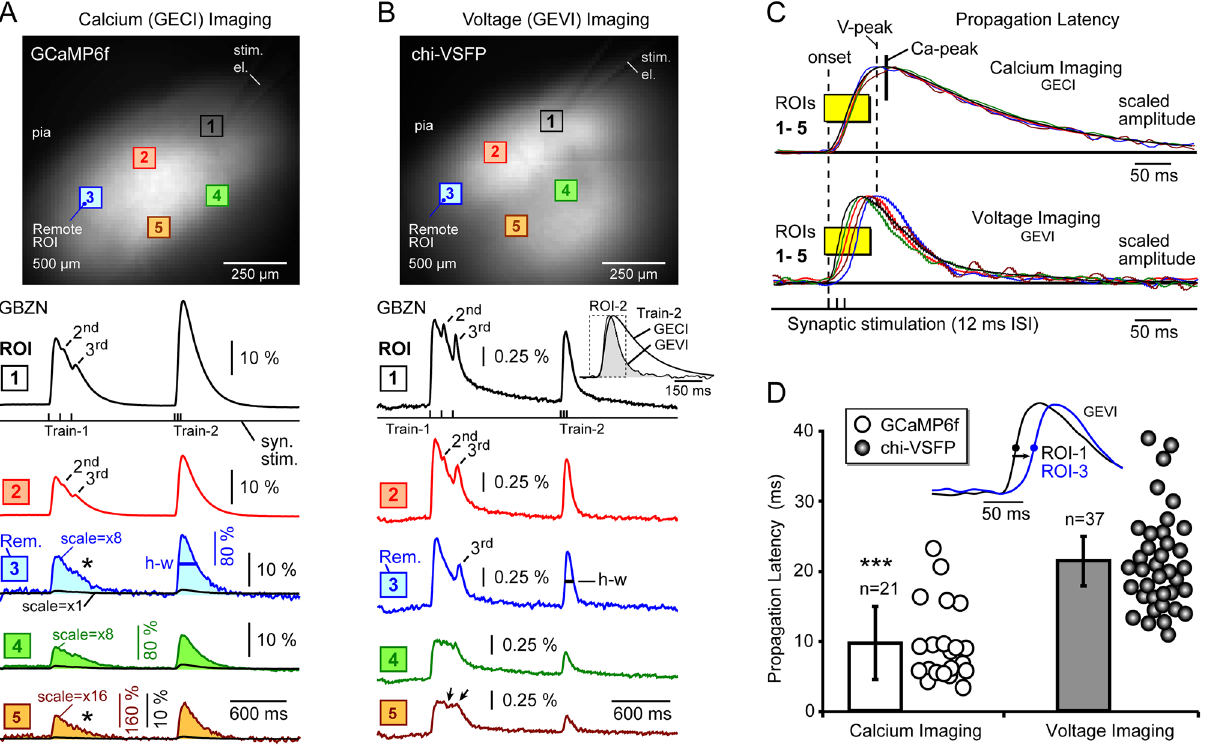
Figure 3. Optical signal propagation—calcium vs. voltage imaging. ( A ) Top, image: Surface of a cortical brain slice prepared from GCaMP6f animal, with ROIs and glass electrode for synaptic stimulation. Bottom, traces: Synaptically-evoked calcium (GECI) transients in the presence of GABA-A receptor antagonist, gabazine, GBZN [10 µM]. Synaptic stimulation comprised two triplets, 8.3 Hz ( Train-1 ) and 83 Hz ( Train-2 ), respectively. Optical traces were recorded simultaneously from 5 ROIs. The remote traces (ROI-3-4-5) are shown at two amplifications: × 1 (black) and × 8, × 16 (color). Asterisk marks uneventful waveform. ( B ) Same as in ( A ), except the brain slice was prepared from a chi-VSFP animal. Black arrows mark fast changes in GEVI waveforms, which are unmatched in the GECI records (asterisk). Inset: Differences in the peak timing and signal duration between a GECI and GEVI trace at ROI-2. ( C ) Traces from ( A ) and ( B ) ( Train-2 ) are amplitude-scaled, time-aligned, and superimposed on a faster time scale. Yellow box on the rising slopes of traces indicates the amplitude level (half-amplitude) at which latencies were quantified. Note that voltage transients (bottom) show a greater variety of signal latencies compared to the calcium transients (top). Vertical dashed line “onset” marks the onset of synaptic stimulation. Vertical dashed line “ V-peak ” marks the peak of the most delayed voltage transient (ROI-3). Thick vertical line “ Ca-peak ” marks the peak of the GCaMP6f transients. ( D ) Inset: Propagation latency between two ROIs was measured at half-amplitude. White bar is an average latency measured at 500 µm away from the stimulation site, obtained in 21 recordings from 6 brain slices treated with gabazine, in 3 GCaMP animals (mean ± stdev). Gray bar is an average 500 µm latency obtained in 37 recordings from 15 GBZN-treated brain slices, in 6 chi-VSFP animals, p <